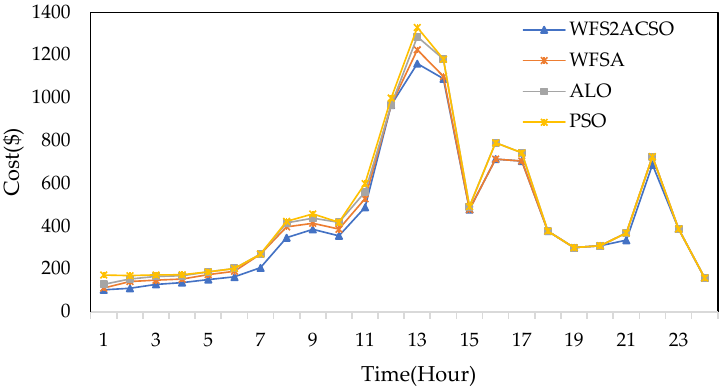
Figure 16. Cost comparison of various techniques for industrial area.